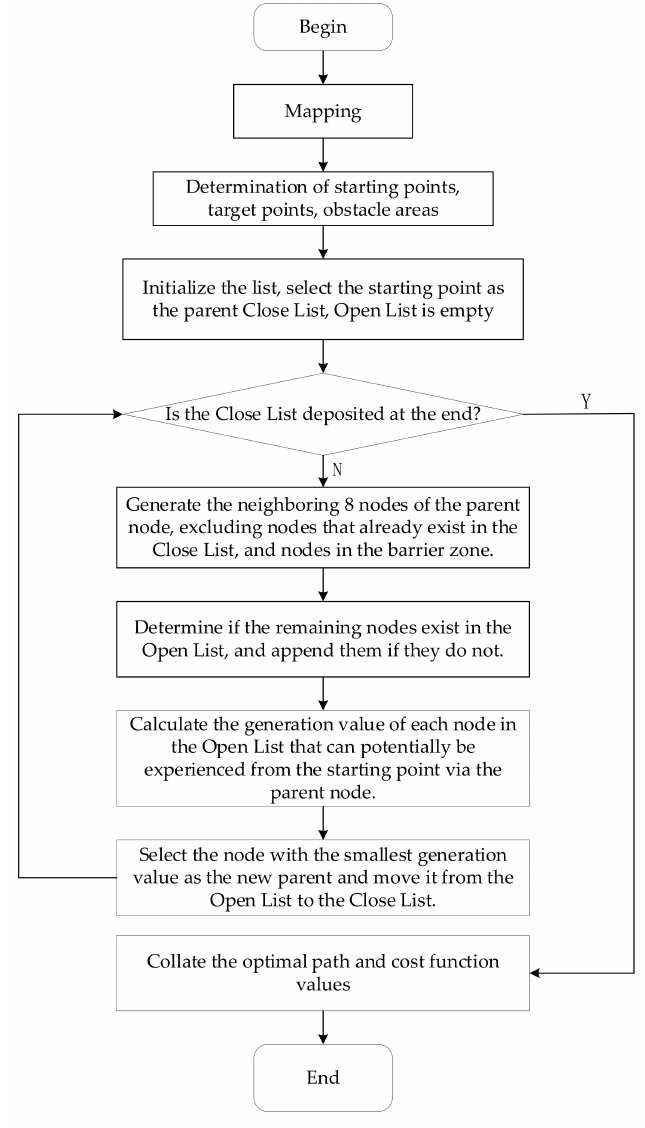
Figure 13. Flow chart of the A*